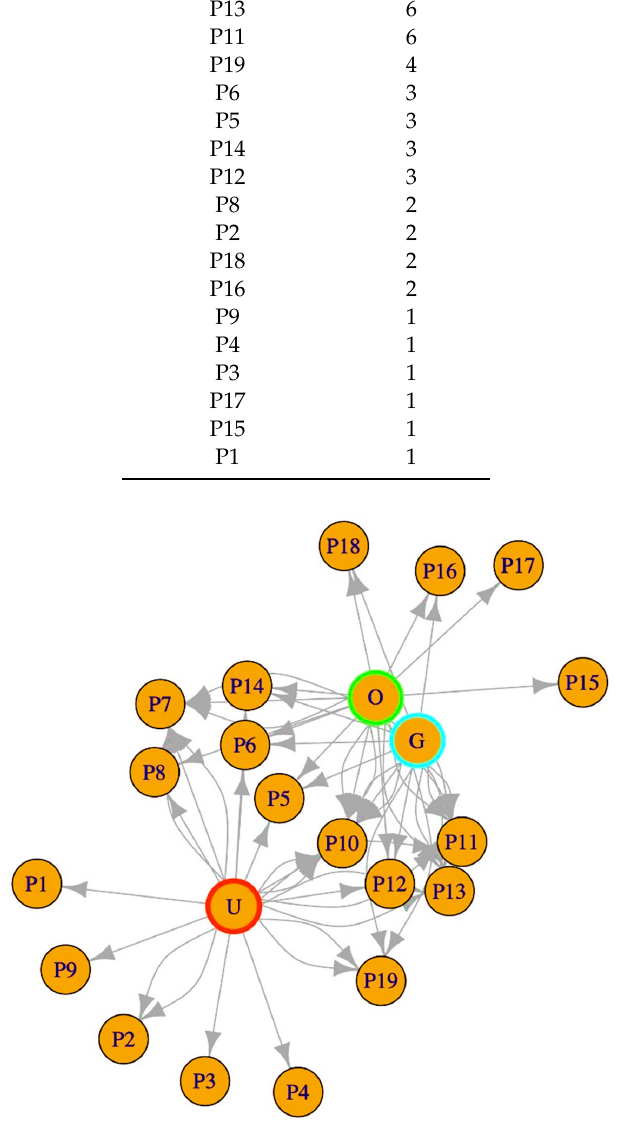
Figure 3. The network of stakeholder ‐ associated problems.